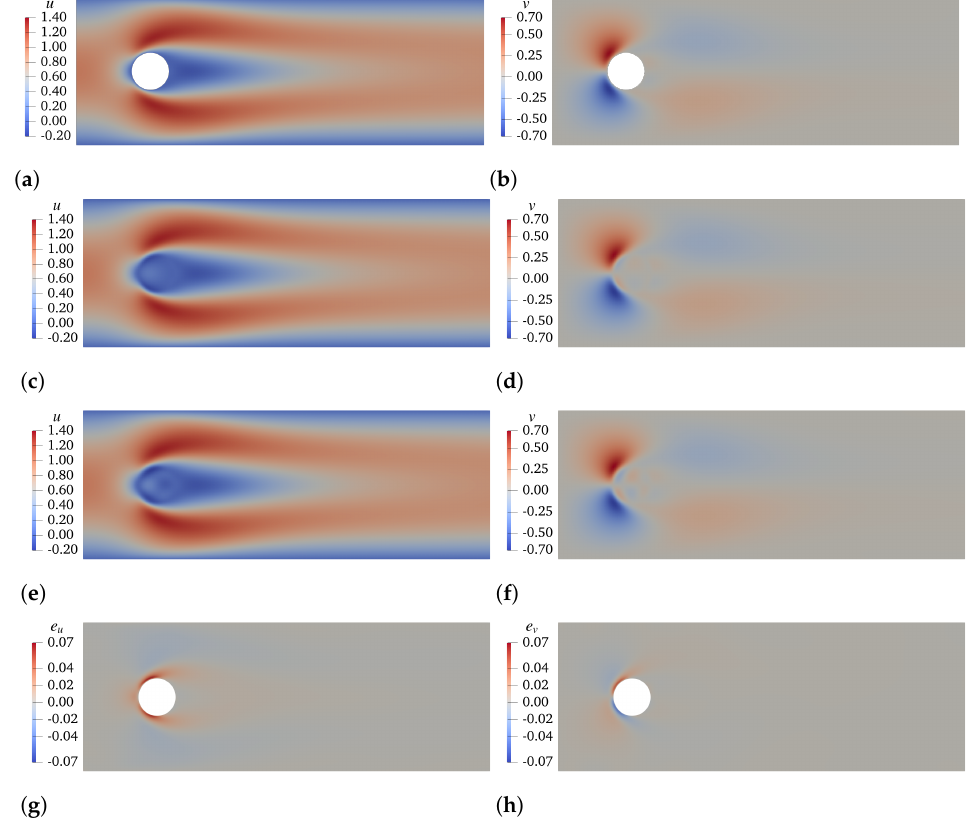
Figure 5. A comparison between the contours of velocity components obtained using Fluent, mesh- based IB and IB-PINN. ( a ) u-component (Fluent); ( b ) v-component (Fluent); ( c ) u-component (IB); ( d ) v-component (IB); ( e ) u-component (IB-PINN); ( f ) v-component (IB-PINN); ( g ) difference between IB-PINN and IB (u-component); ( h ) difference between IB-PINN and IB (v-component). In ( g , h ), the interior region is filled with white color, and the data are